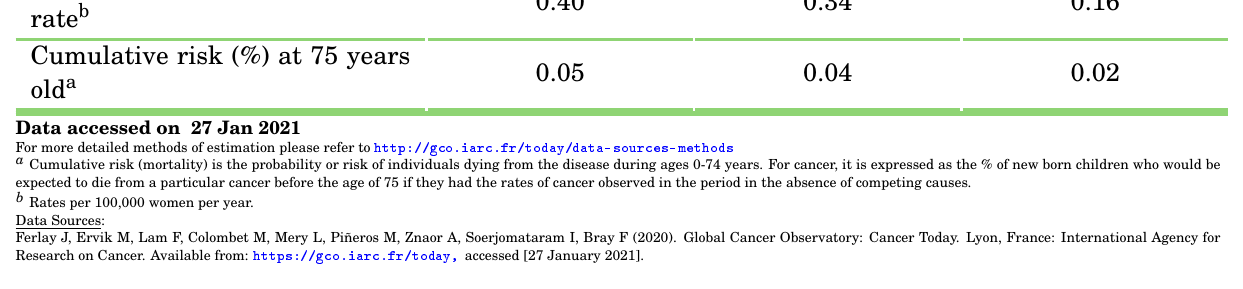
Table 12: Vaginal cancer mortality in India (estimates for 2020) Indicator India Southern Asia World Annual number of deaths 2,723 3,060 Uncertainty intervals [95% UI] [2,198-3,374] Crude mortality rate b 0.41 Age-standardized